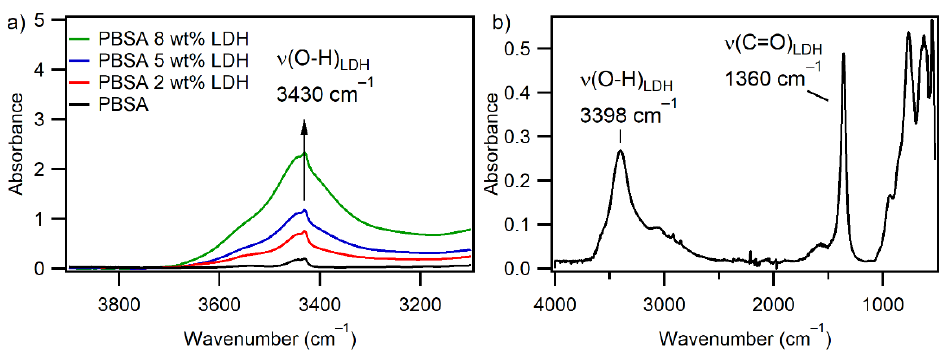
Figure 3. FT-IR spectra in the O-H region of ( a ) PBSA (black line) and PBSA with 2 wt% (red line), 5 wt% (blue line) and 8 wt% (green line) LDH. The peak at 3430 cm − 1 increases with increasing loading of LDH and corresponds to the hydroxides in SORBACID ® 911 whose spectrum is shown in ( b ).